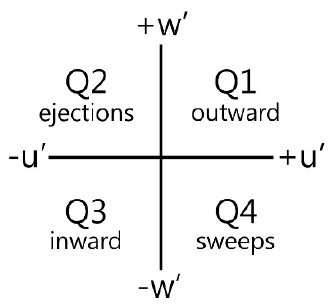
Figure 10. Quadrant plot with ± u (cid:48) and ± w (cid:48) axes. Quadrant 1 (Q1) is associated with outward interactions ( u (cid:48) > 0, w (cid:48) > 0), quadrant 2 (Q2) with ejections ( u (cid:48) < 0, w (cid:48) > 0), quadrant 3 (Q3) with inward interactions ( u (cid:48) < 0, w (cid:48) < 0), and quadrant 4 (Q4) with sweeps ( u (cid:48) > 0, w (cid:48) < 0).